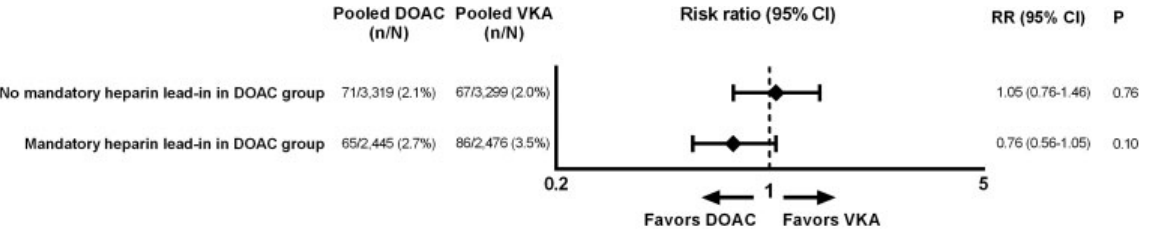
Fig. 1 Relative risk of recurrent venous thromboembolism with or without a heparin lead-in. DOAC, direct oral anticoagulant; VKA, vitamin K